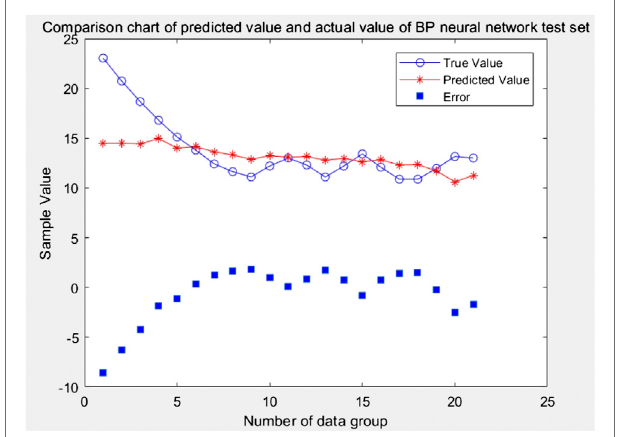
FIGURE3| Comparison between thetrue value and the predicted value of the carbon price in Fujian province.